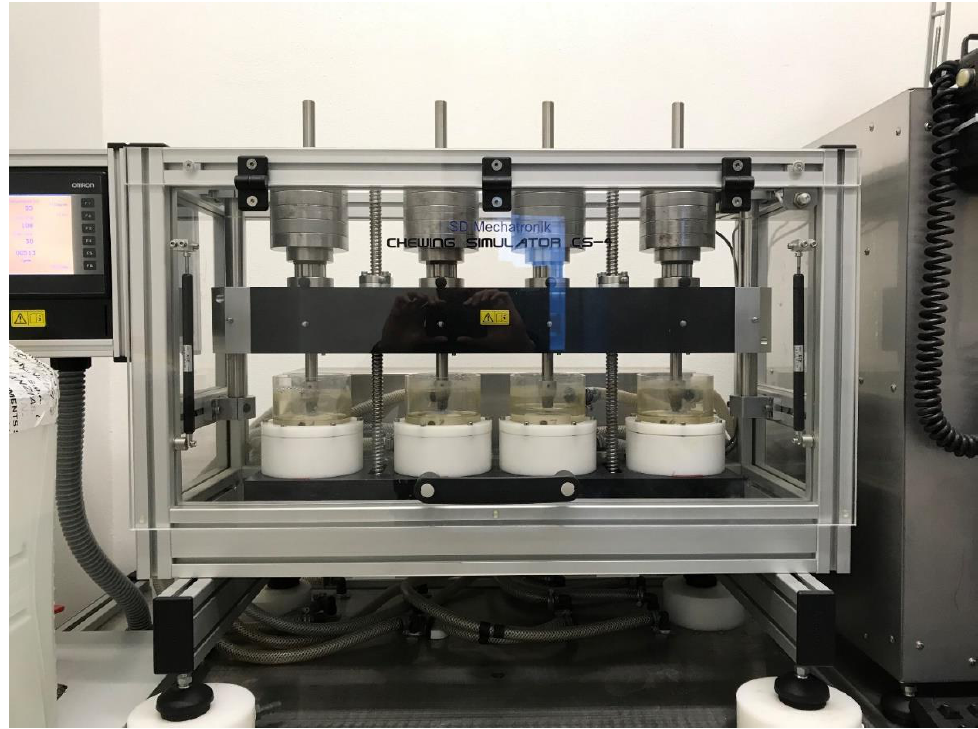
Figure 3. The chewing simulator (CS-4.4, SD Mechatronik). Materials 2019 , 11 , x FOR PEER REVIEW